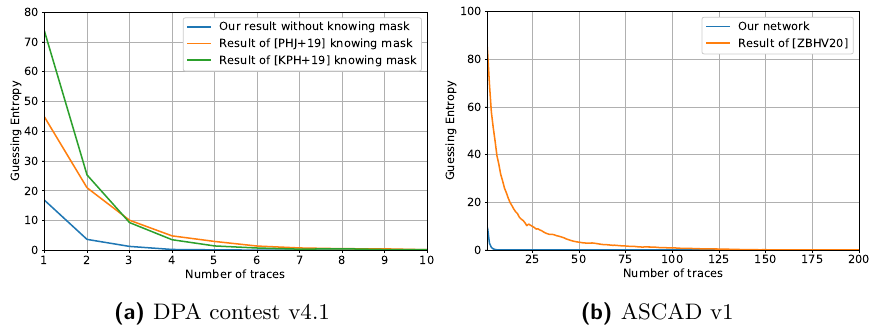
Figure 36: Comparisons of guessing